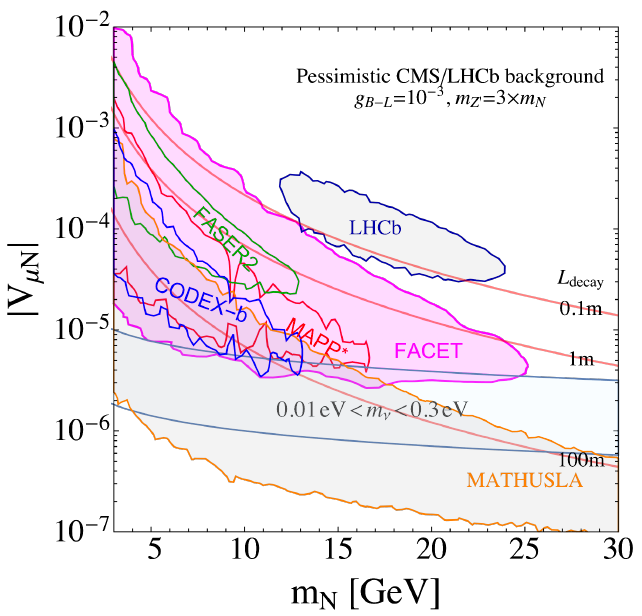
Figure 4 . FACET reach in the mixing parameter vs. mass plane for a heavy neutral lepton (3 event contours), along with projections for other proposed experiments, as well as for MAPP and the upgraded LHCb detectors